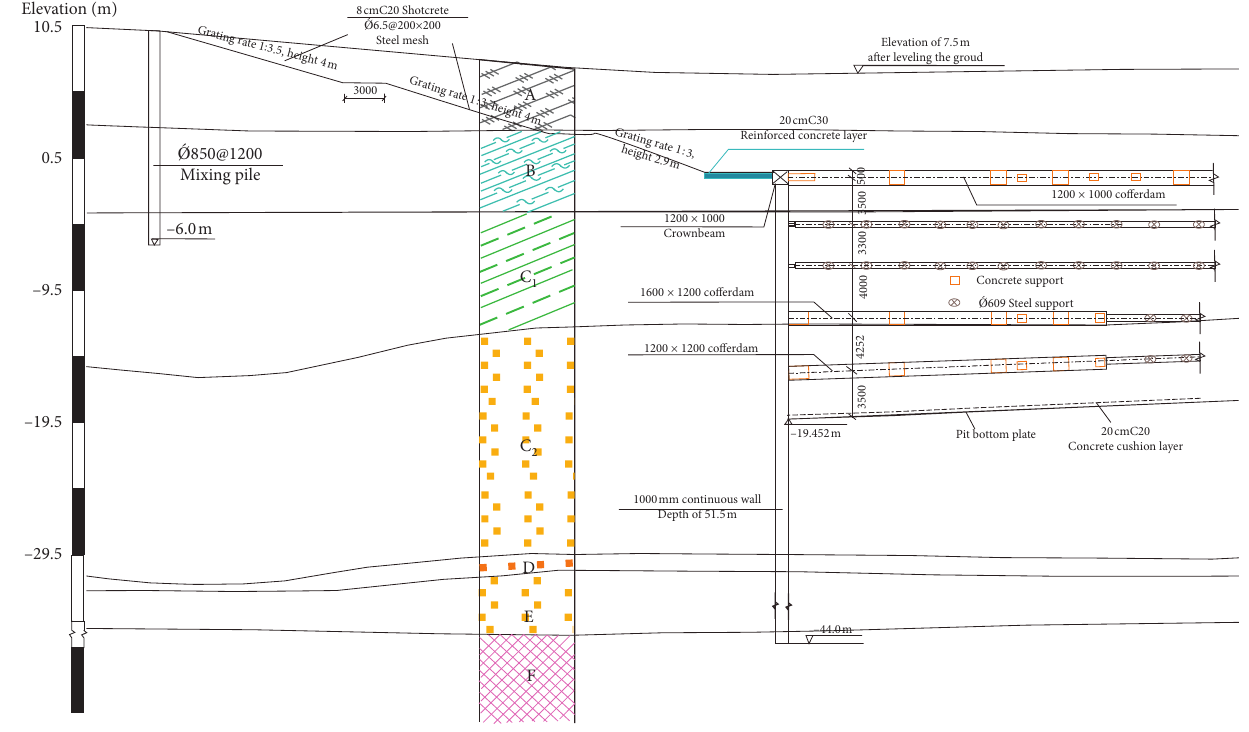
Figure 5: Schematic diagram of the supporting structure in the NW